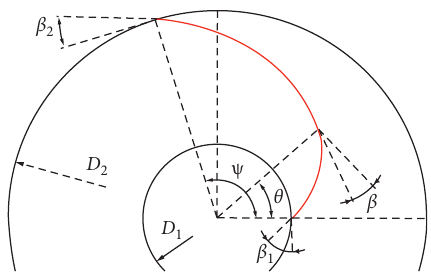
Figure 3: Blade profile of logarithmic spiral